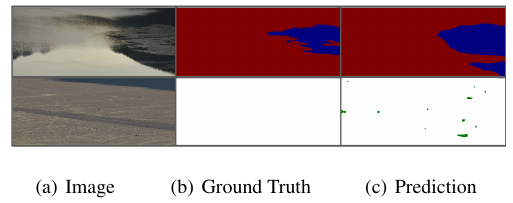
Figure 10: Cam0 results when the model is trained only on Cam1.